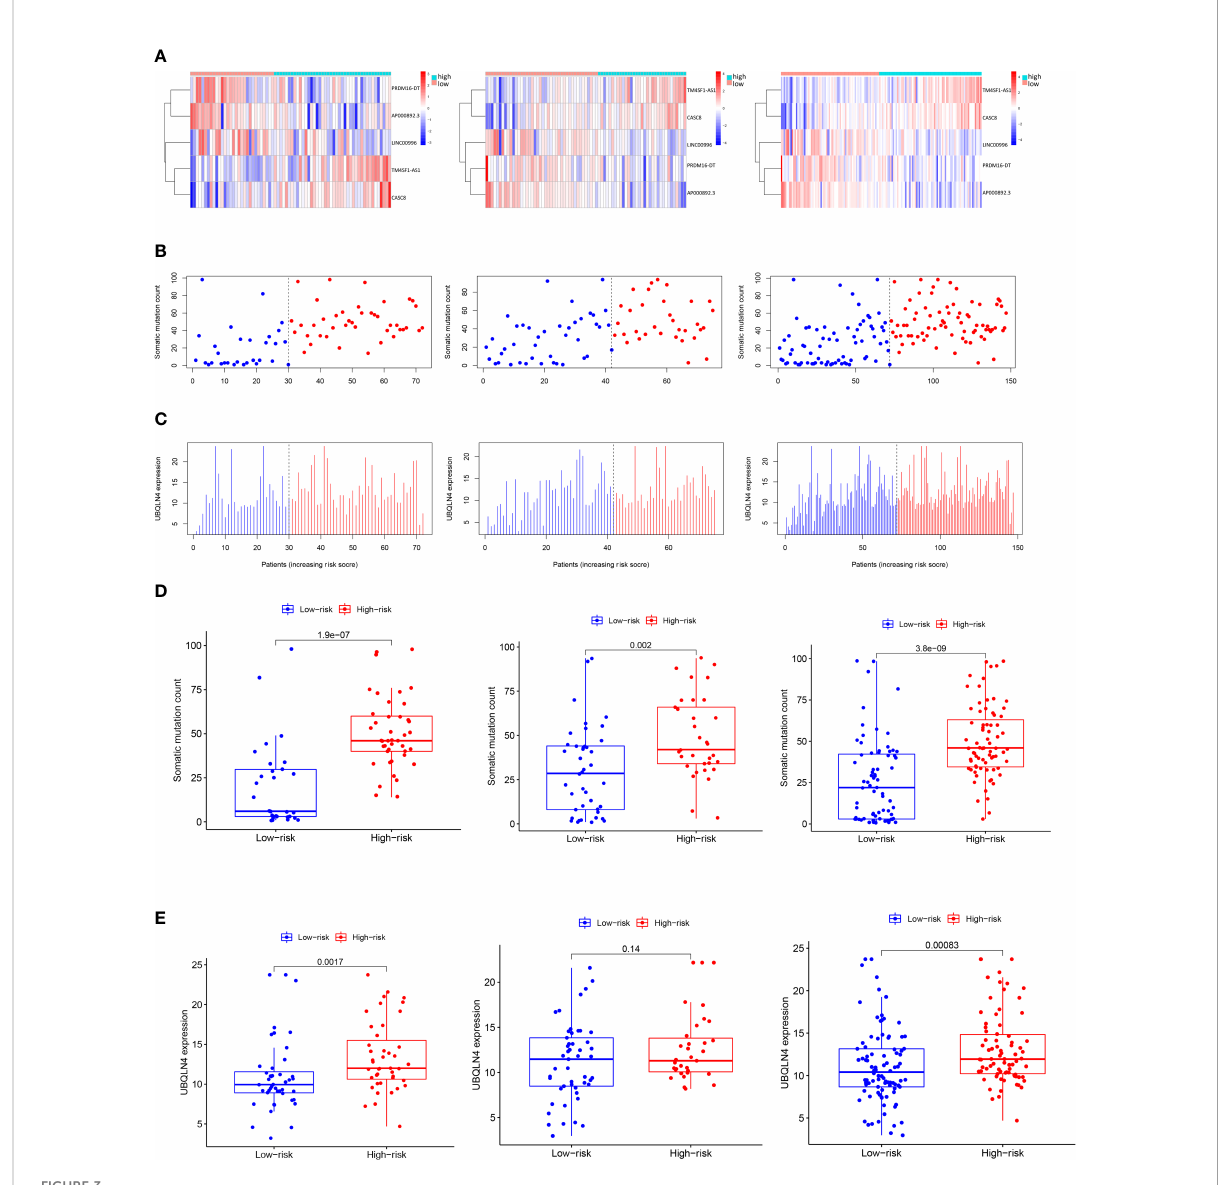
FIGURE 3 Visualization of the interconnection between GILncSig risk score and expression levels of fi ve siglncRNAs, somatic mutation counts and expression level of UBQLN4. (A) Patients in the training set, testing set and the combined TCGA cohort were ranked from left to right on the X- axis according to ascending GILncSig risk score, while the expression levels of the fi ve siglncRNAs were shown on the Y-axis. (B) Distribution of somatic mutation counts with increasing GILncSig score as X axis. (C) Distribution of UBQLN4 expression level with increasing GILncSig score as X axis. (D) Box plots of somatic mutations in the training set, testing set and the combined TCGA cohort in the high- and low-risk groups. Somatic mutation counts in the high-risk group were signi fi cantly higher than those in the low-risk group. (E) Box plots of UBQLN4 expression levels in the training set, testing set and the combined TCGA cohort in both the high-risk and low-risk groups. The UBQLN4 expression level was signi fi cantly higher in the high-risk group than in the low-risk group. Statistical analysis was performed using the Mann-Whitney U